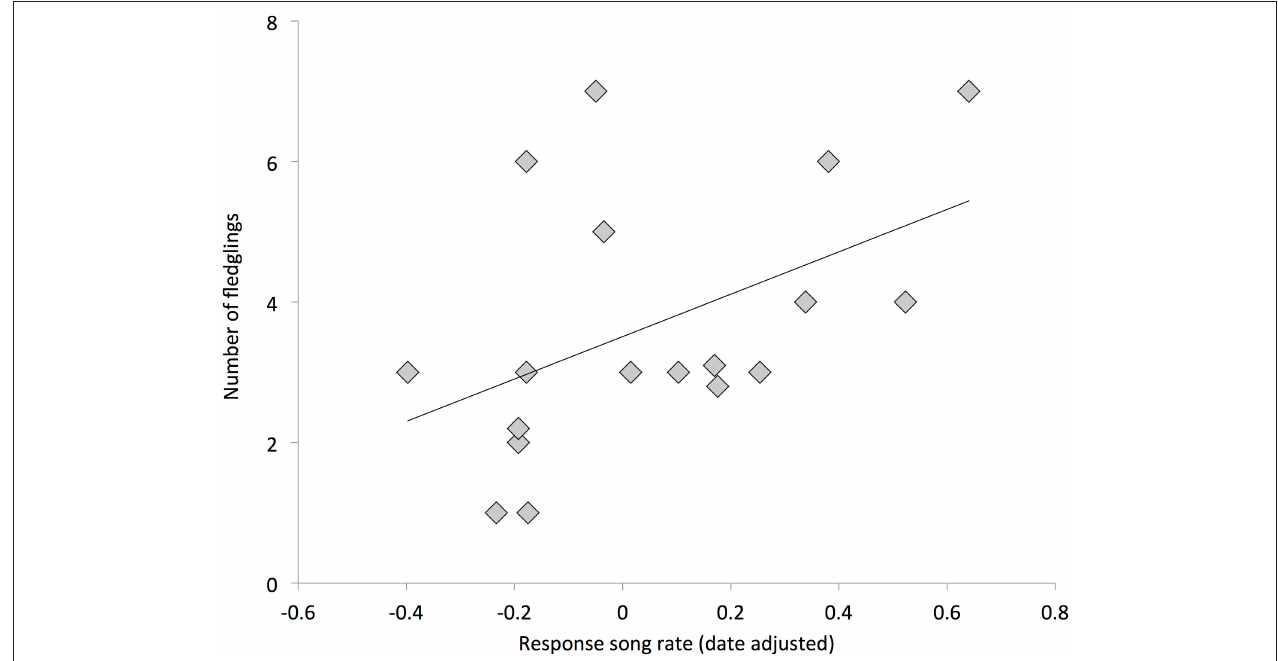
FIGURE 3 | Relationship between female response song rates and total fledglings produced (among successful females); overlapping points are jittered for clarity. Line is from a linear